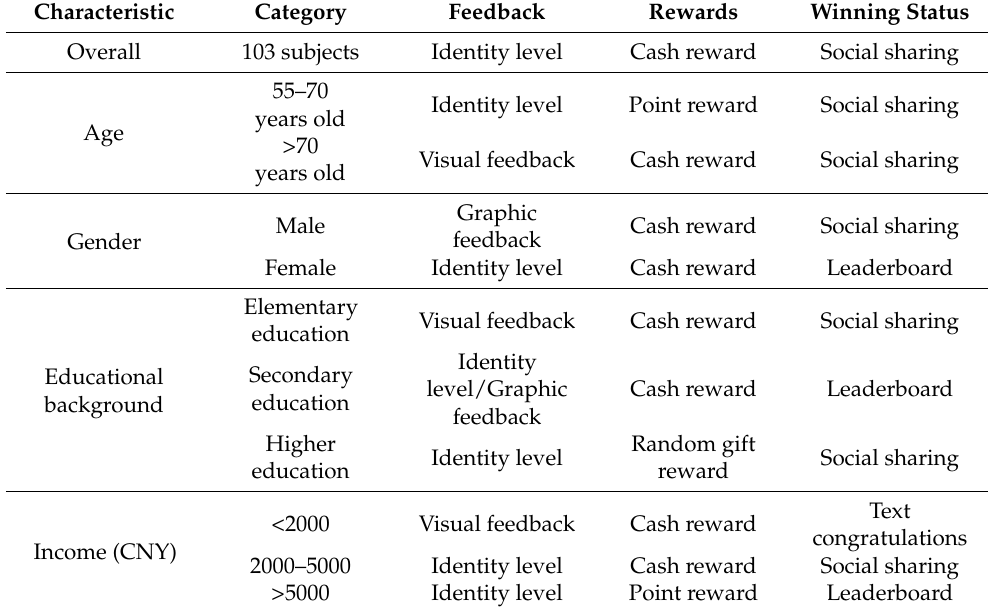
Table 12. The optimal combination of gamification elements for different characteristics of older